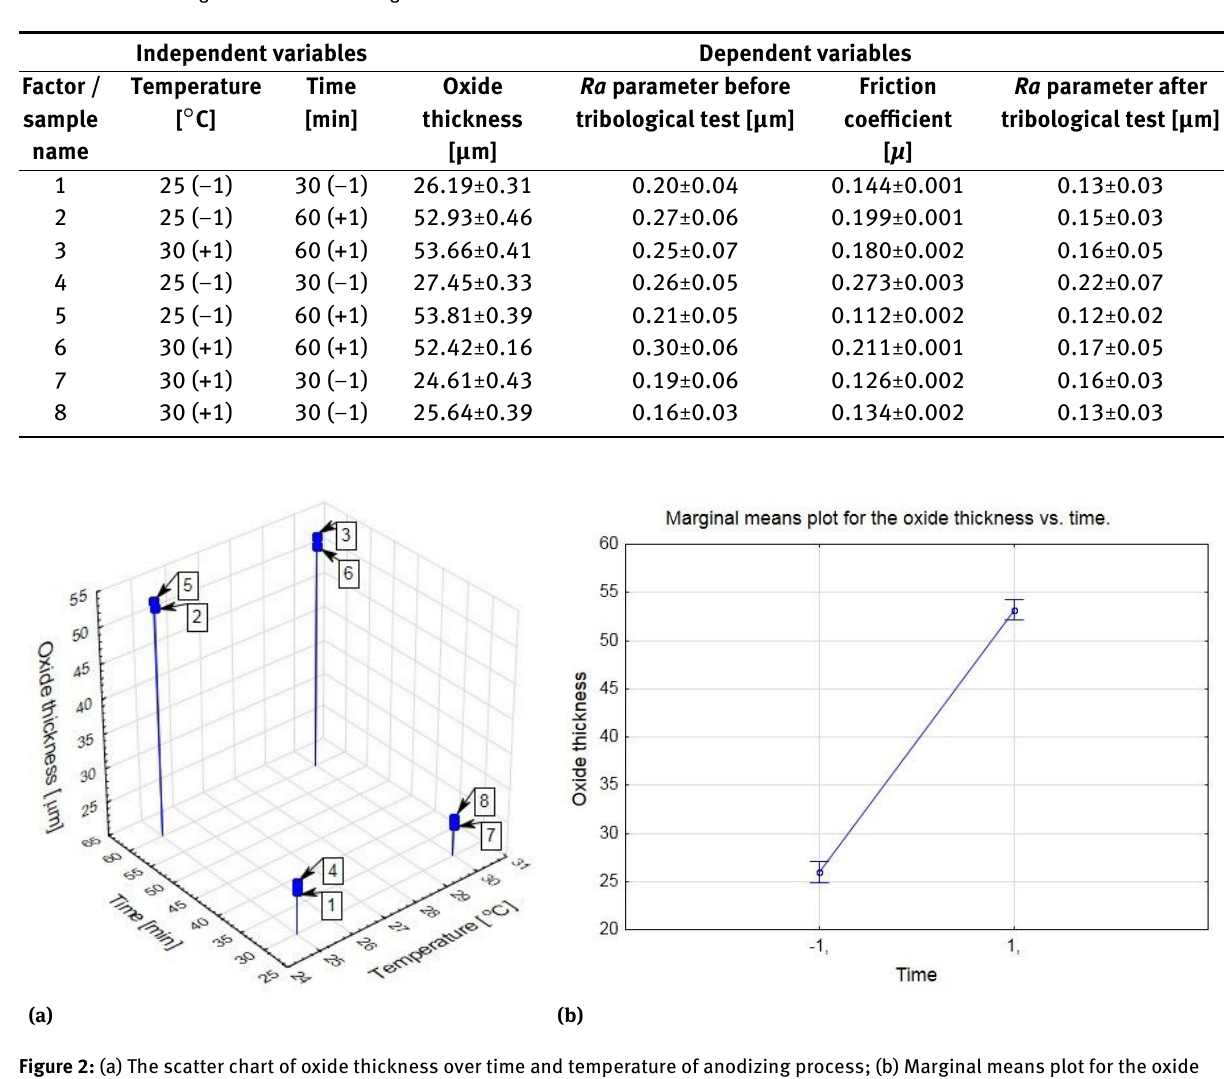
with thickness above 20 µm, which is a satisfactory value for a tribological